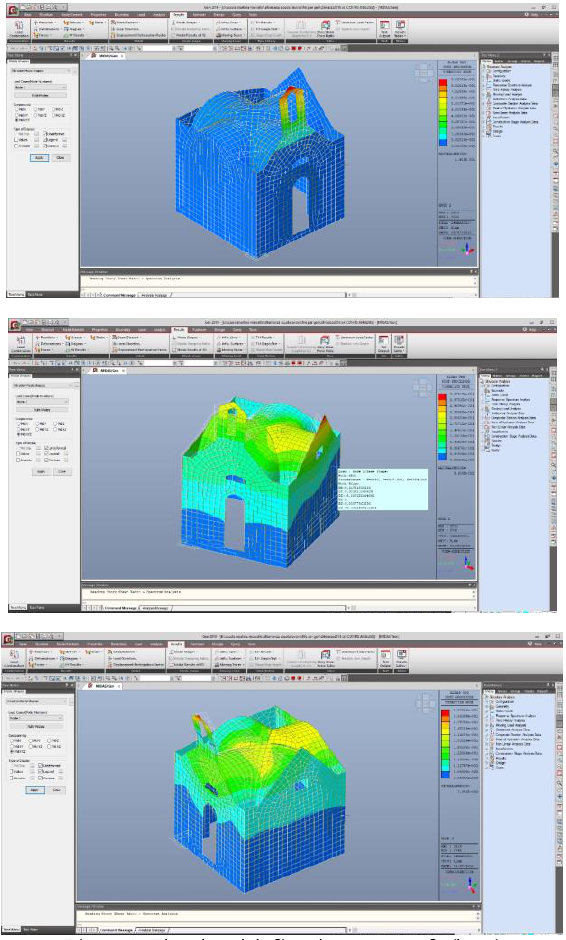
Figure 9. The church's first three ways of vibrating